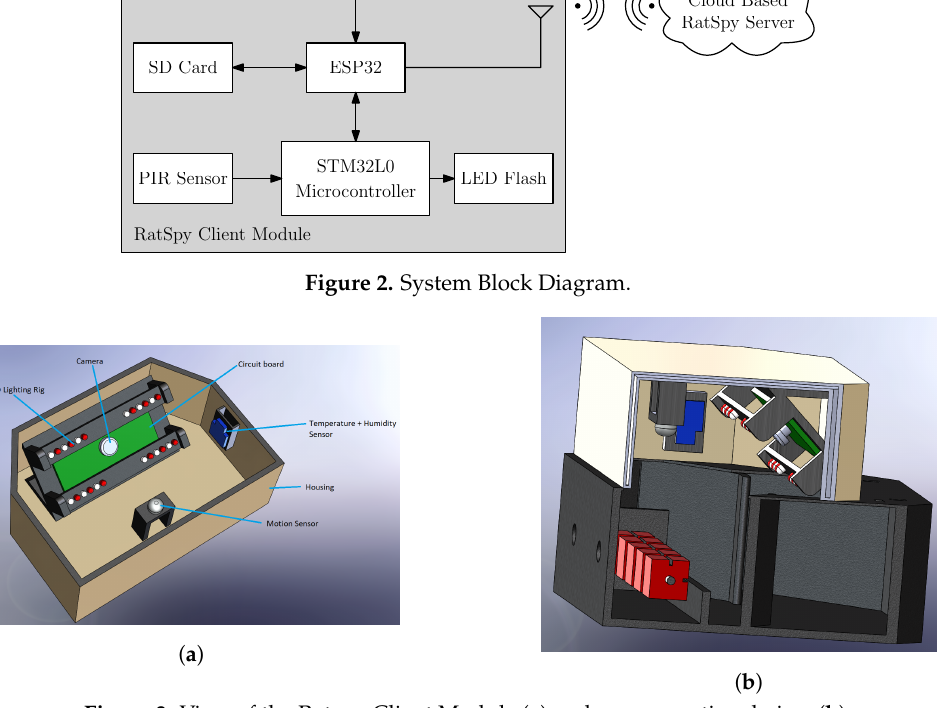
Figure 3. View of the Ratspy Client Module ( a ) and a cross-sectional view ( b